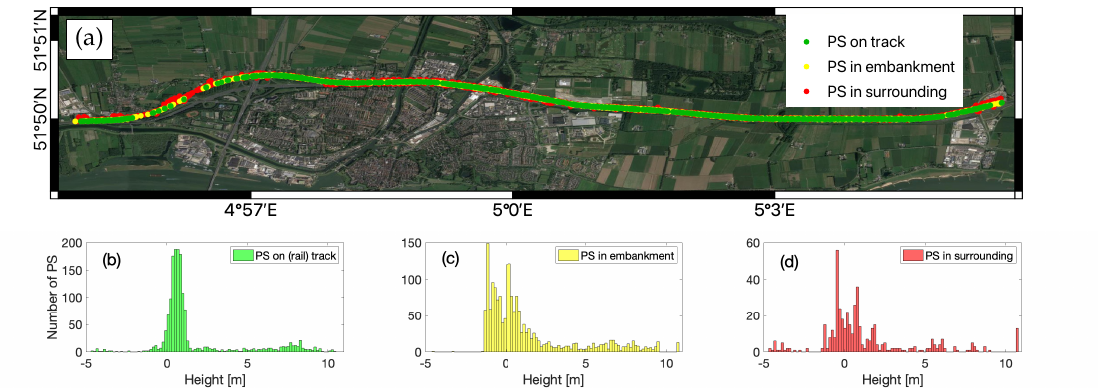
Figure 7. ( a ) Classification of PS associated to railway infrastructure. Height histogram of PS on track in green ( b ), PS in embankment in yellow ( c ), and PS in surrounding in red ( d